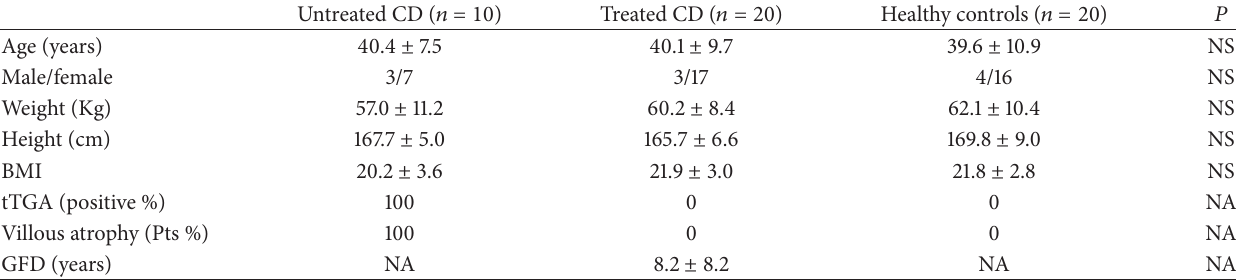
Table 1: Clinical and demographic parameters of the enrolled subjects.